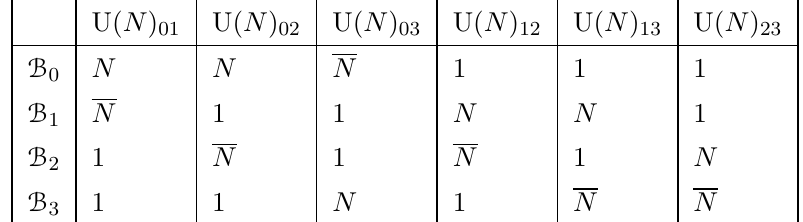
Table 1 . Representation content of super(cid:12)elds, where 1 is the trivial representation and N; N are the fundamental and anti-fundamental representations, respectively.